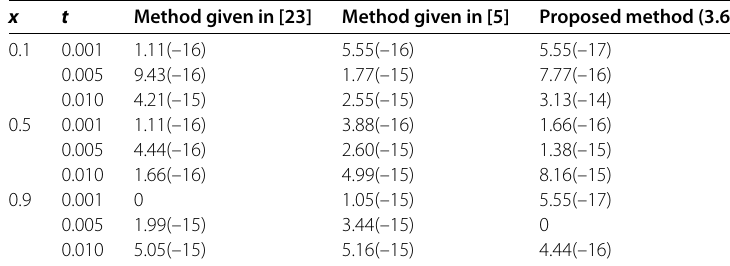
Table 1 Example 1: Case 1.1(a)(i): Maximum absolute errors at δ = 1